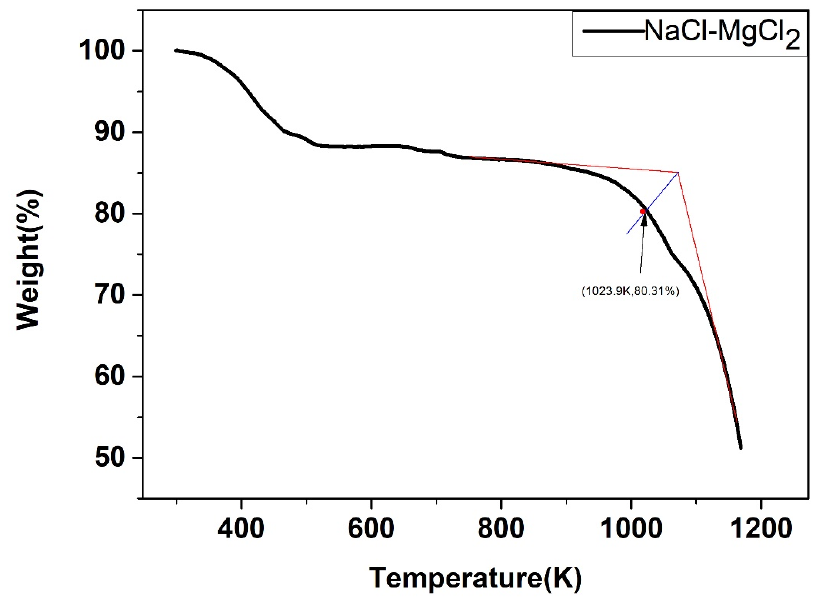
Figure 25. Weight change (wt.%) of the NaCl-MgCl 2 binary chloride salt.